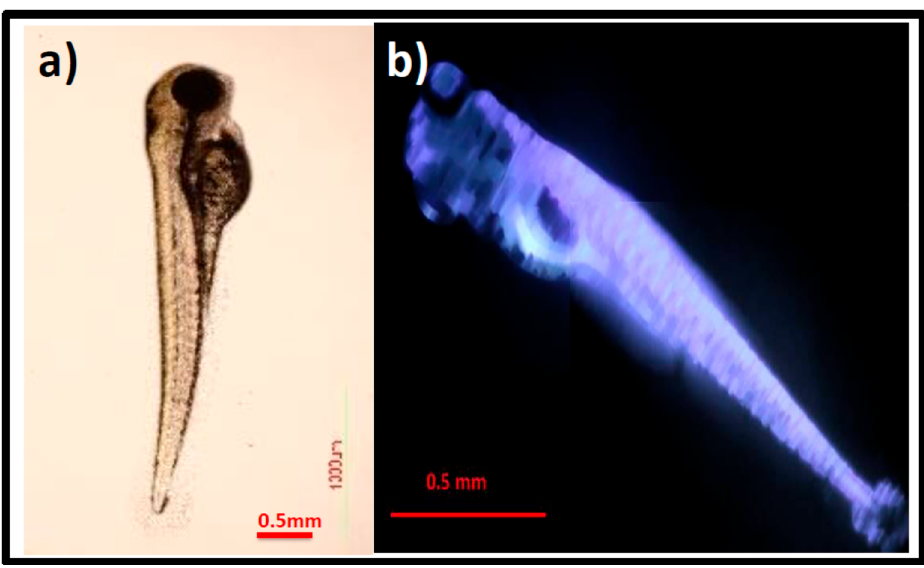
Figure 7. ( a ) Control (0 µg/mL) optical image of zebrafish. ( b ) Fluorescence image of GOQDs treated zebrafish (100 µg/mL). The images recorded at 96 hpf. zebrafish (100 µ g/mL). The images recorded at 96